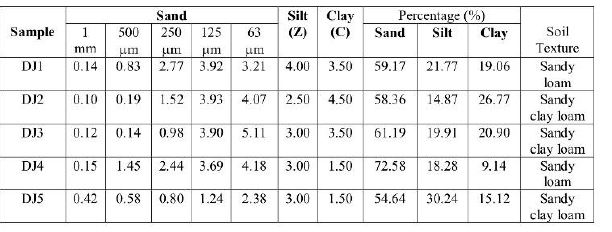
Table 2: Soil loss estimation